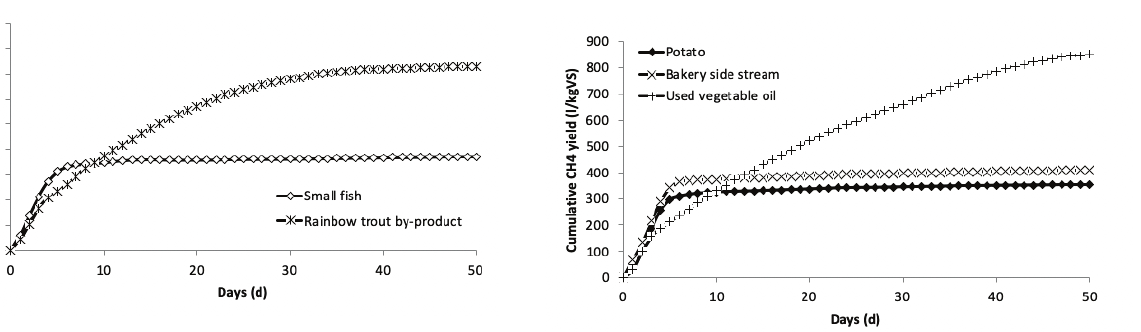
Figure 3: 50-day cumulative CH4-production curves of reindeer meat production by- fig3